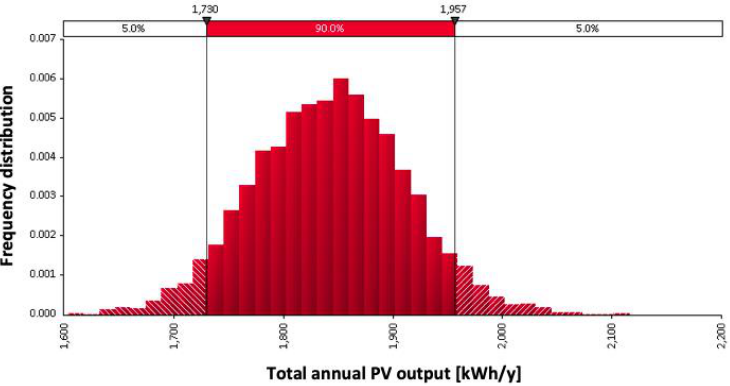
Figure 8. Total annual measured energy produced by the PV array.